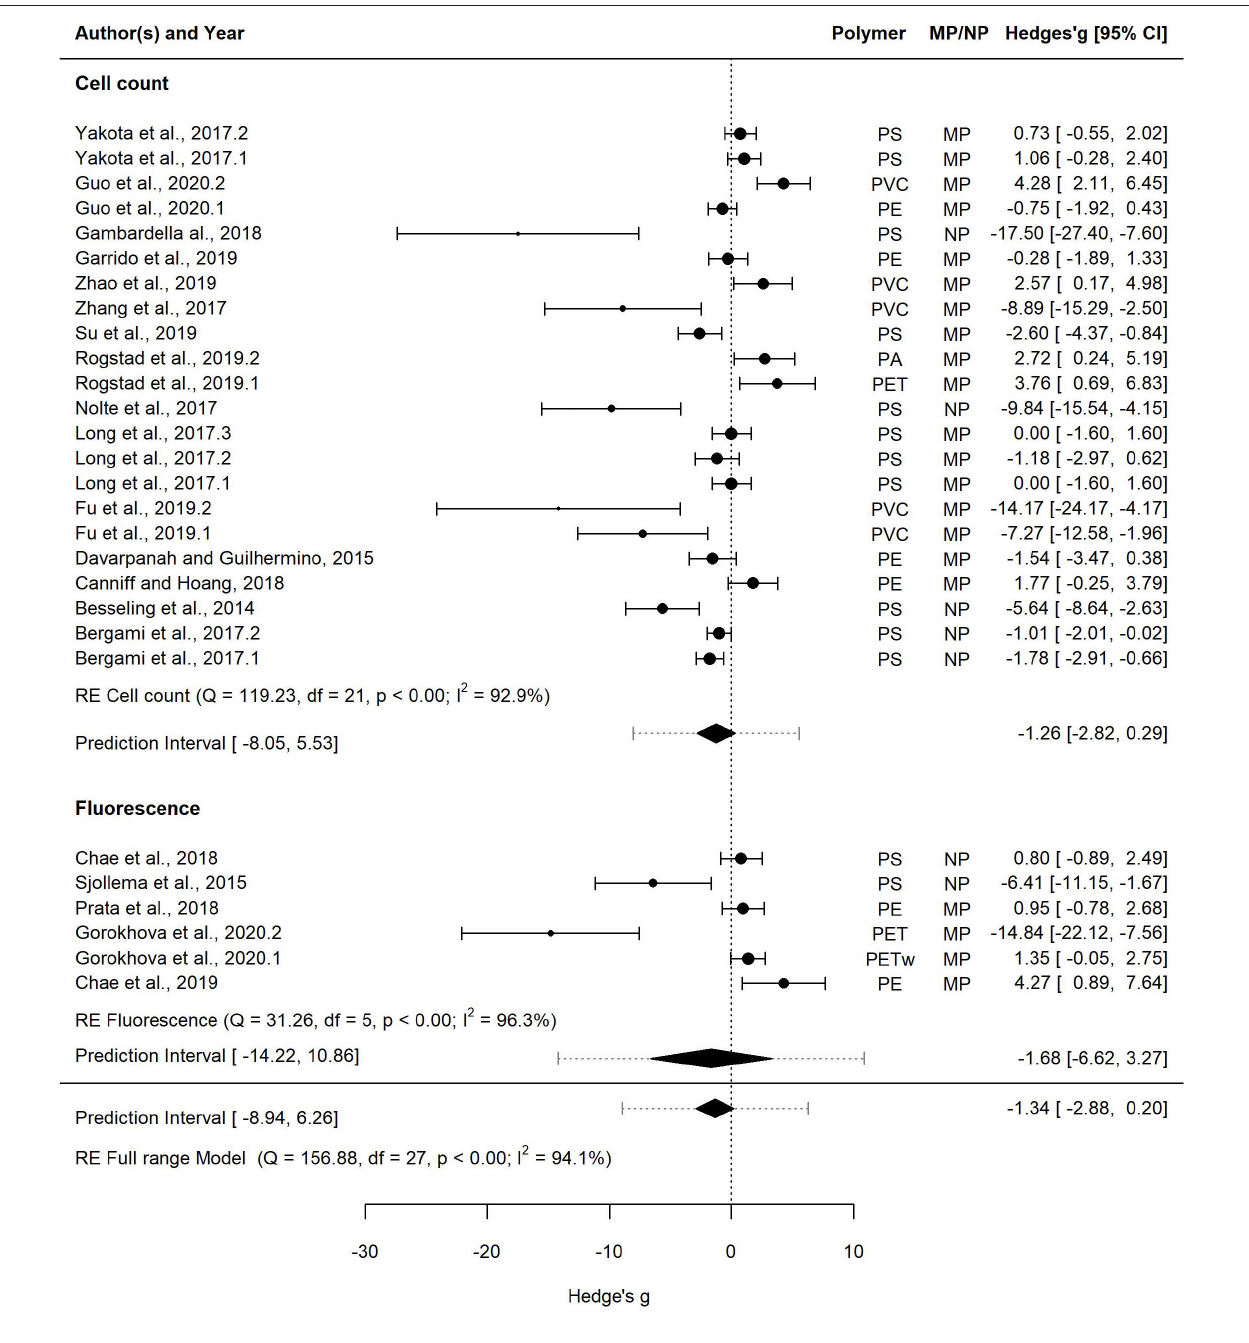
FIGURE 6 | Forest plot of the random-effect model for effect sizes estimated as Hedges’ g and the associated 95% confidence interval (95% CI) in Forest plot for the Full range model (28 entries). Symbol size for individual entries is proportional to the study weight. The overall effect (pooled estimate) on growth according to the random-effect model is depicted as a diamond. The prediction interval (PI) is shown with lines extending from the diamond. Multiple entries for some studies correspond to different polymers tested within a study or several species used in the tests. Studies that employed cell count and fluorescence methods for measuring growth are shown